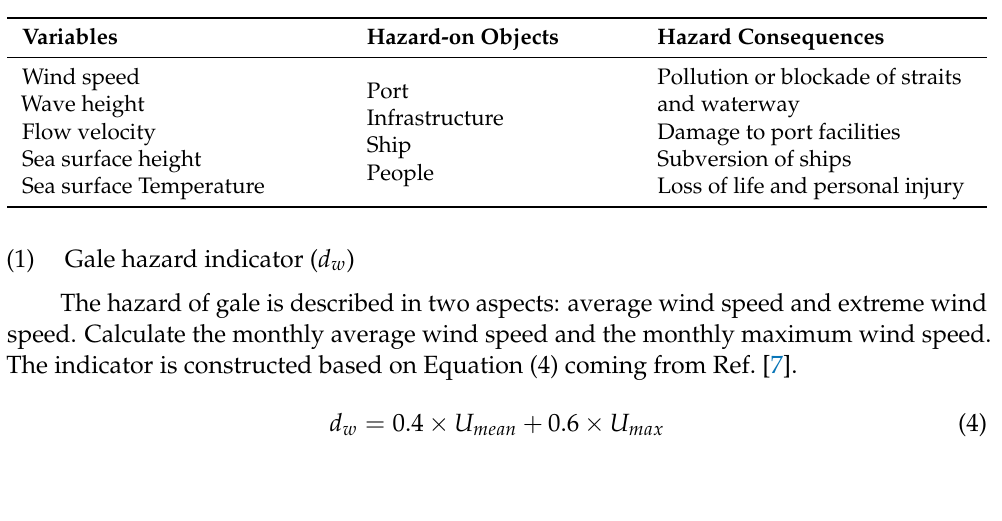
Table 2. The mode of action of